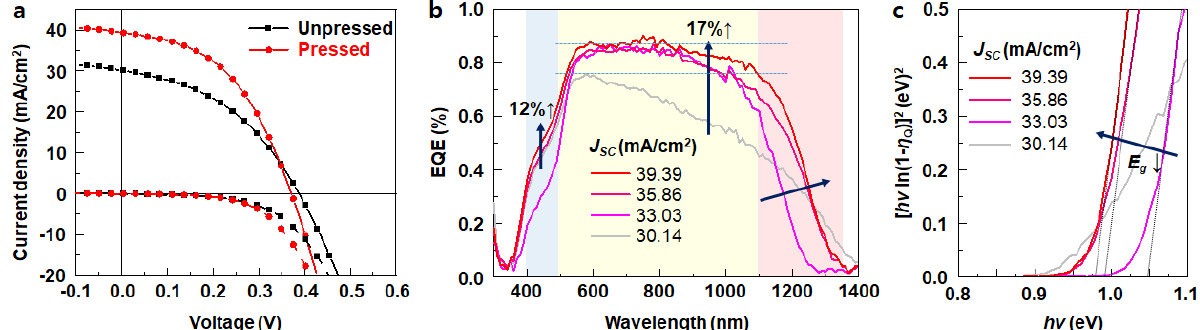
Figure 7. Photovoltaic performance of CZTSe thin film solar cells: ( a ) j ‐ V curves under AM 1.5G illumination and in the dark; ( b ) external quantum efficiency (EQE) spectra; and ( c ) bandgaps of CZTSe thin film solar cells without a bias light under short ‐ circuit conditions of unpressed (grey line) and pressed cells (reddish lines).